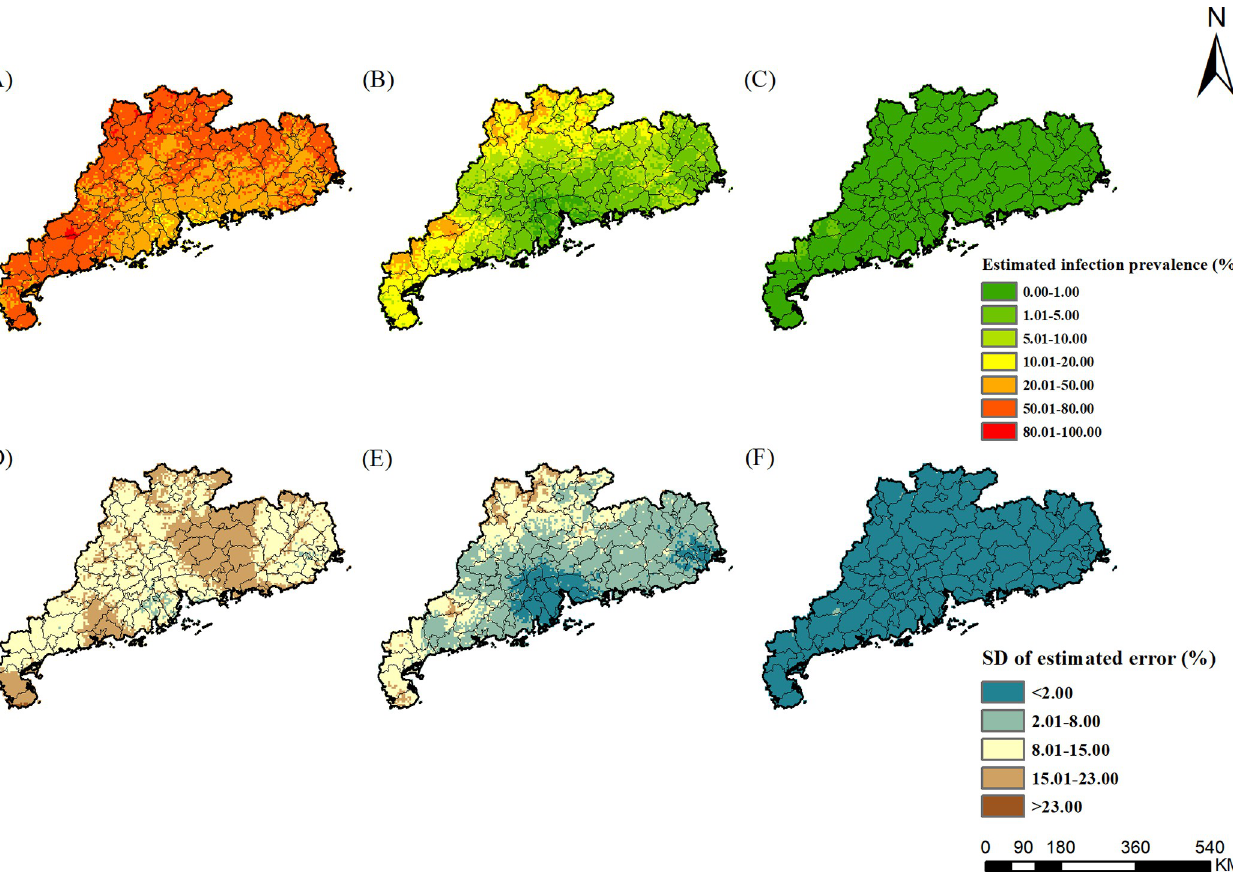
Fig 2. The geographical distribution of A . lumbricoide infection risk in Guangdong. (A)-(C) present A . lumbricoide infection during the periods of 1988– 1992, 2002–2003, and 2015–2016, respectively. (D)-(F) present the corresponding standard deviation of the estimated uncertainty. The base layer derived from https://www.webmap.cn/mapDataAction.do?method=forw&keysearch=indexSearch with credit to National Catalogue Service For Geographic Information. https://doi.org/10.1371/journal.pntd.0010622.g002 PLOS NeglectedTropical Diseases | https://doi.org/10.1371/journal.pntd.0010622 July 18,